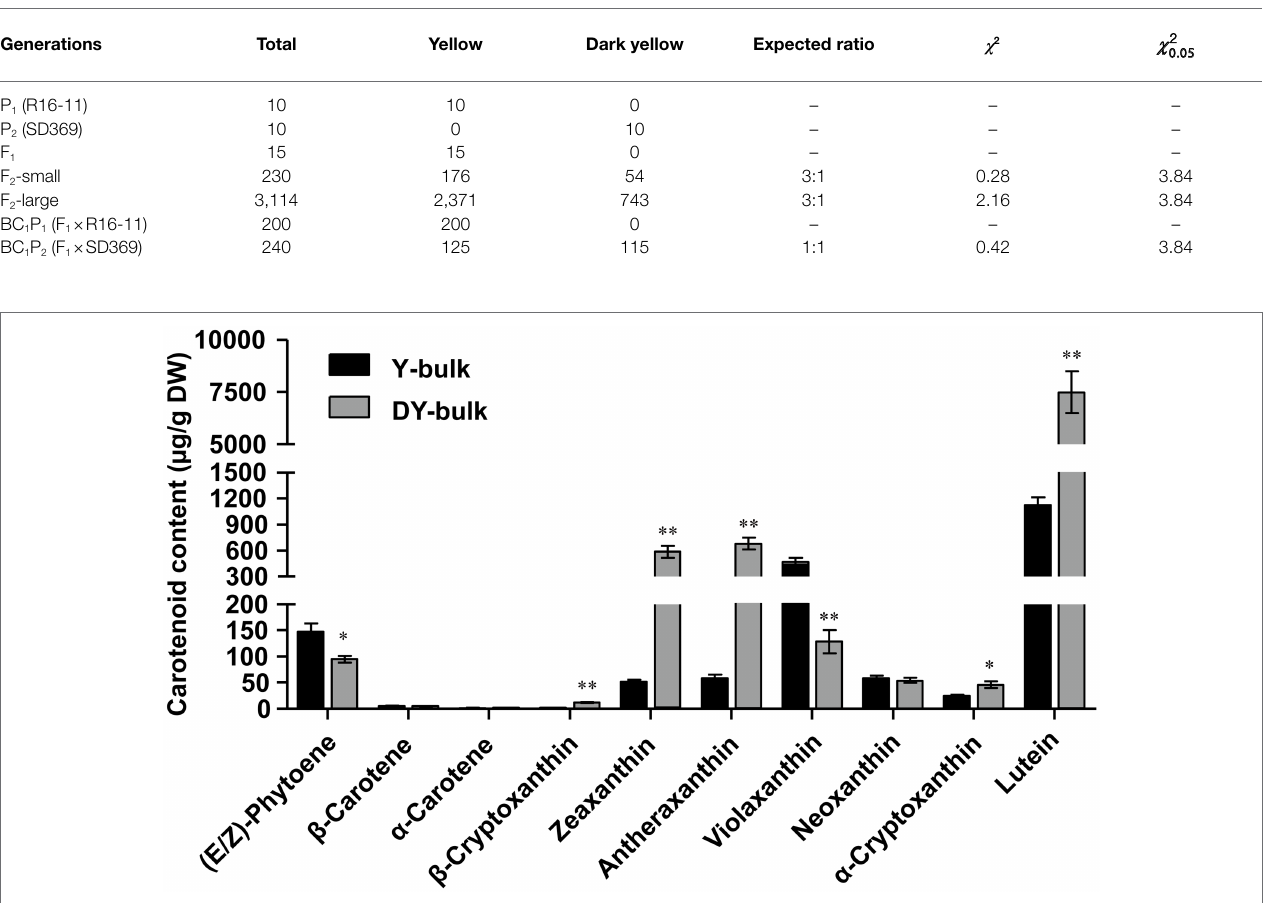
FIGURE 2 | Carotenoid composition in petals from Y-bulk and DY-bulk. Carotenoids extracts from yellow and dark yellow petals were subjected to UPLC-APCI- MS/MS system under saponification treatment. Error bars indicate SE ( n = 3). Value of * p < 0.05 (Student’s t -test). Value of ** p < 0.01 (Student’s t